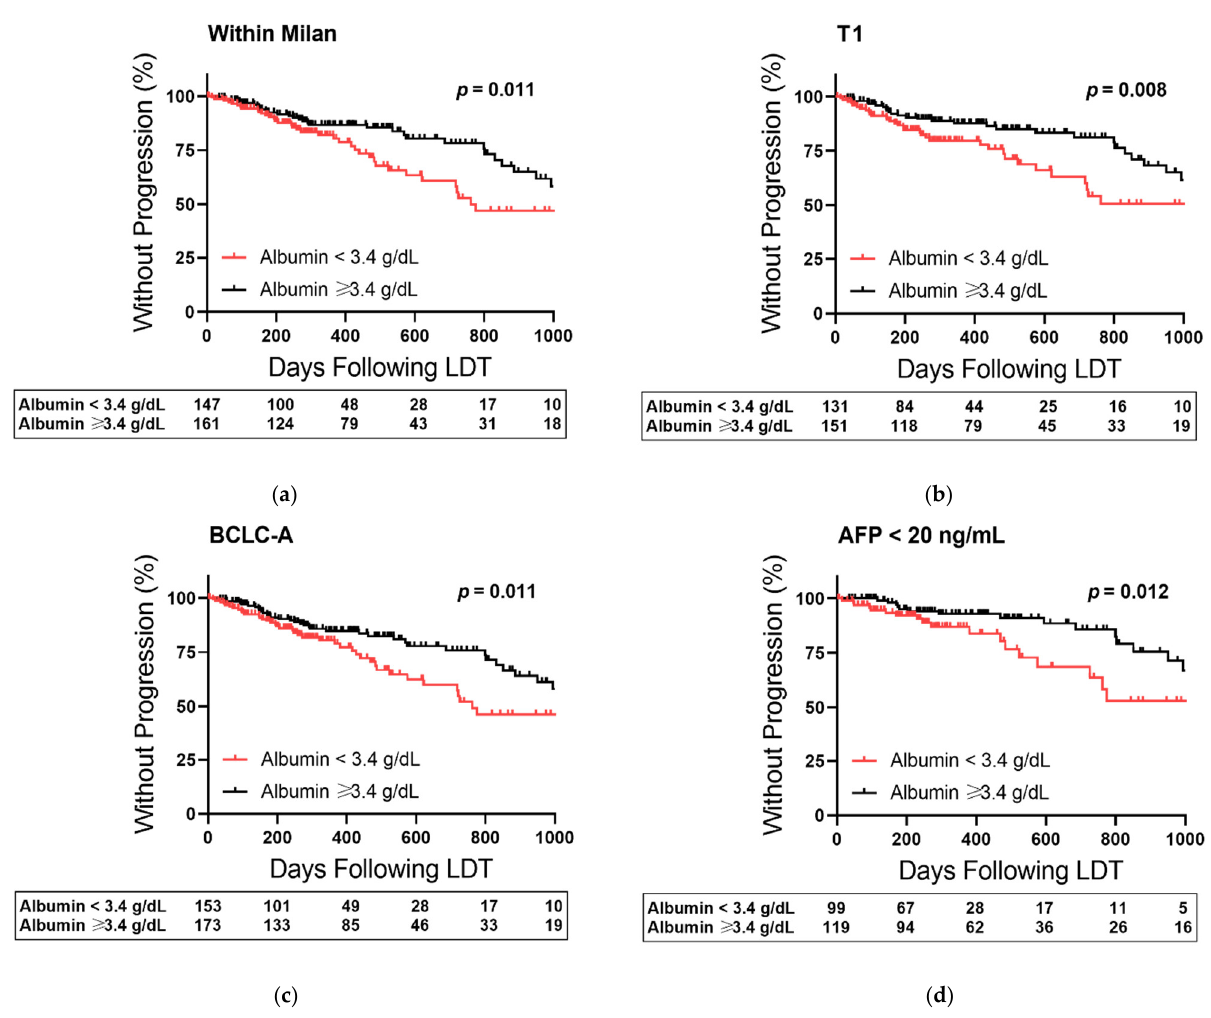
Figure 4. Albumin-Stratified Kaplan–Meier Curves of Time to Progression Based Upon HCC Burden and Biomarker Risk Factors following Liver-Directed Therapy (LDT). ( a ) Plot restricted to patients within Milan Criteria at diagnosis. ( b ) Plot restricted to patients with T1 stage burden at diagnosis. ( c ) Plot restricted to patients with Barcelona Clinic Liver Cancer (BCLC) Stage A disease at diagnosis. ( d ) Plot restricted to patients with a baseline alpha-fetoprotein (AFP) level < 20 ng/mL. Censored data is marked with a vertical upward dash. The total number of patients remaining in the analysis at each major x-axis time point is listed in the table below the plot. Significance was determined using the Log-Rank test.